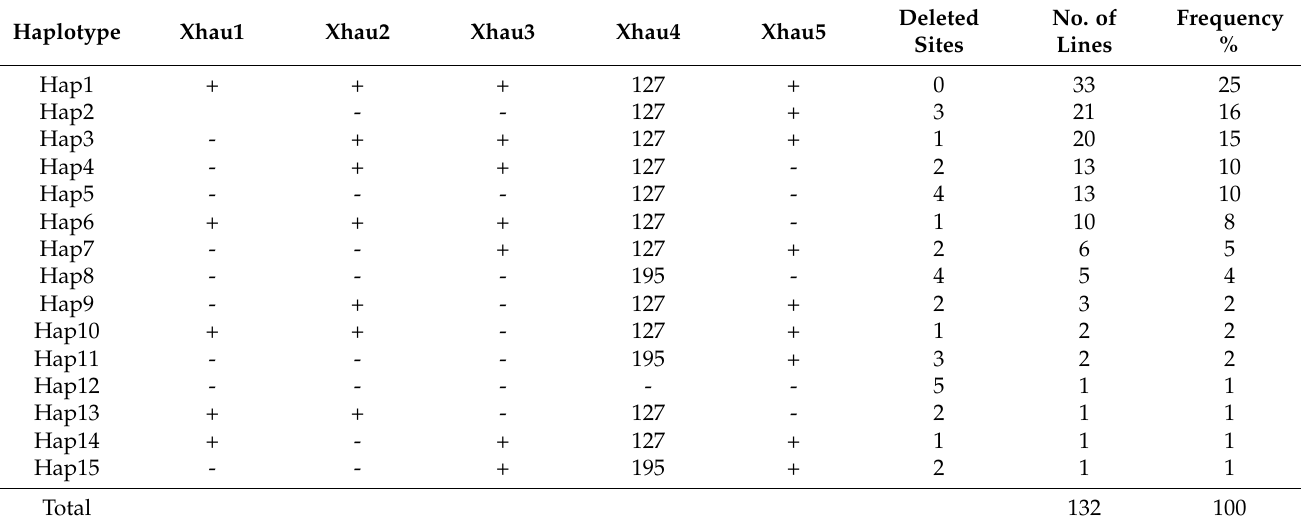
Table 5. Description of haplotypes for the TaHST1 locus, including frequency (%) in the diversity panel of synthetic hexaploid